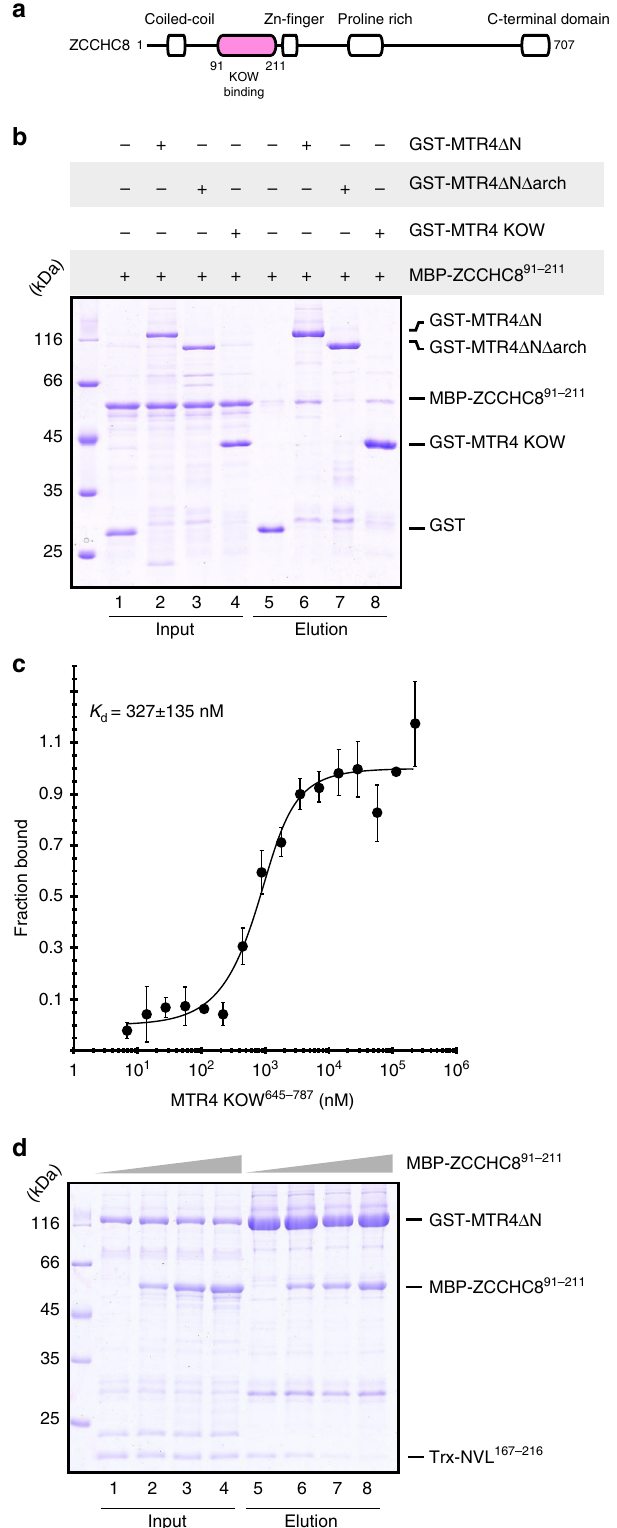
Fig. 4 The N-terminus of ZCCHC8 interacts with the MTR4 KOW domain. a Schematic representation of the domain organization of ZCCHC8. Domain boundaries are obtained from previous studies 37,43 and computational sequence analysis. b Protein co-precipitations by pull down assays. GST-tagged MTR4 Δ N, MTR4 Δ N Δ arch, and MTR4 KOW were